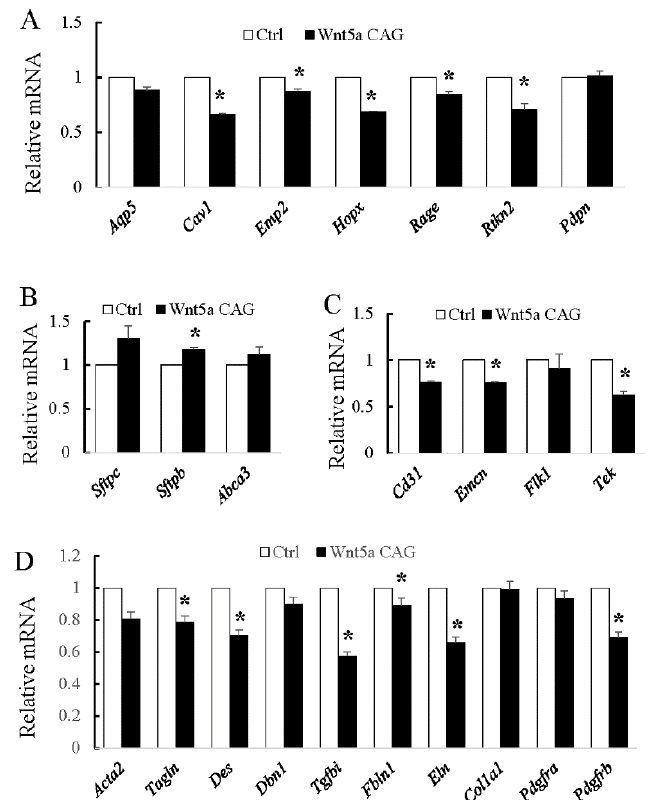
Figure 2. Wnt5a inactivation attenuates differentiation of AT1 and endothelial cells and myofibroblasts during the saccular stage of lung development. A – D: Relative mRNA for AT1 ( A ), AT2 ( B ), endothelial ( C ) and myofibroblast ( D ) markers in E18 Wnt5a CAG lungs (Wnt5a CAG) compared to control lungs by real-time RT-PCR analysis. Data represent the mean ± standard error of the mean (SEM). * indicates p < 0.05. n = 3.